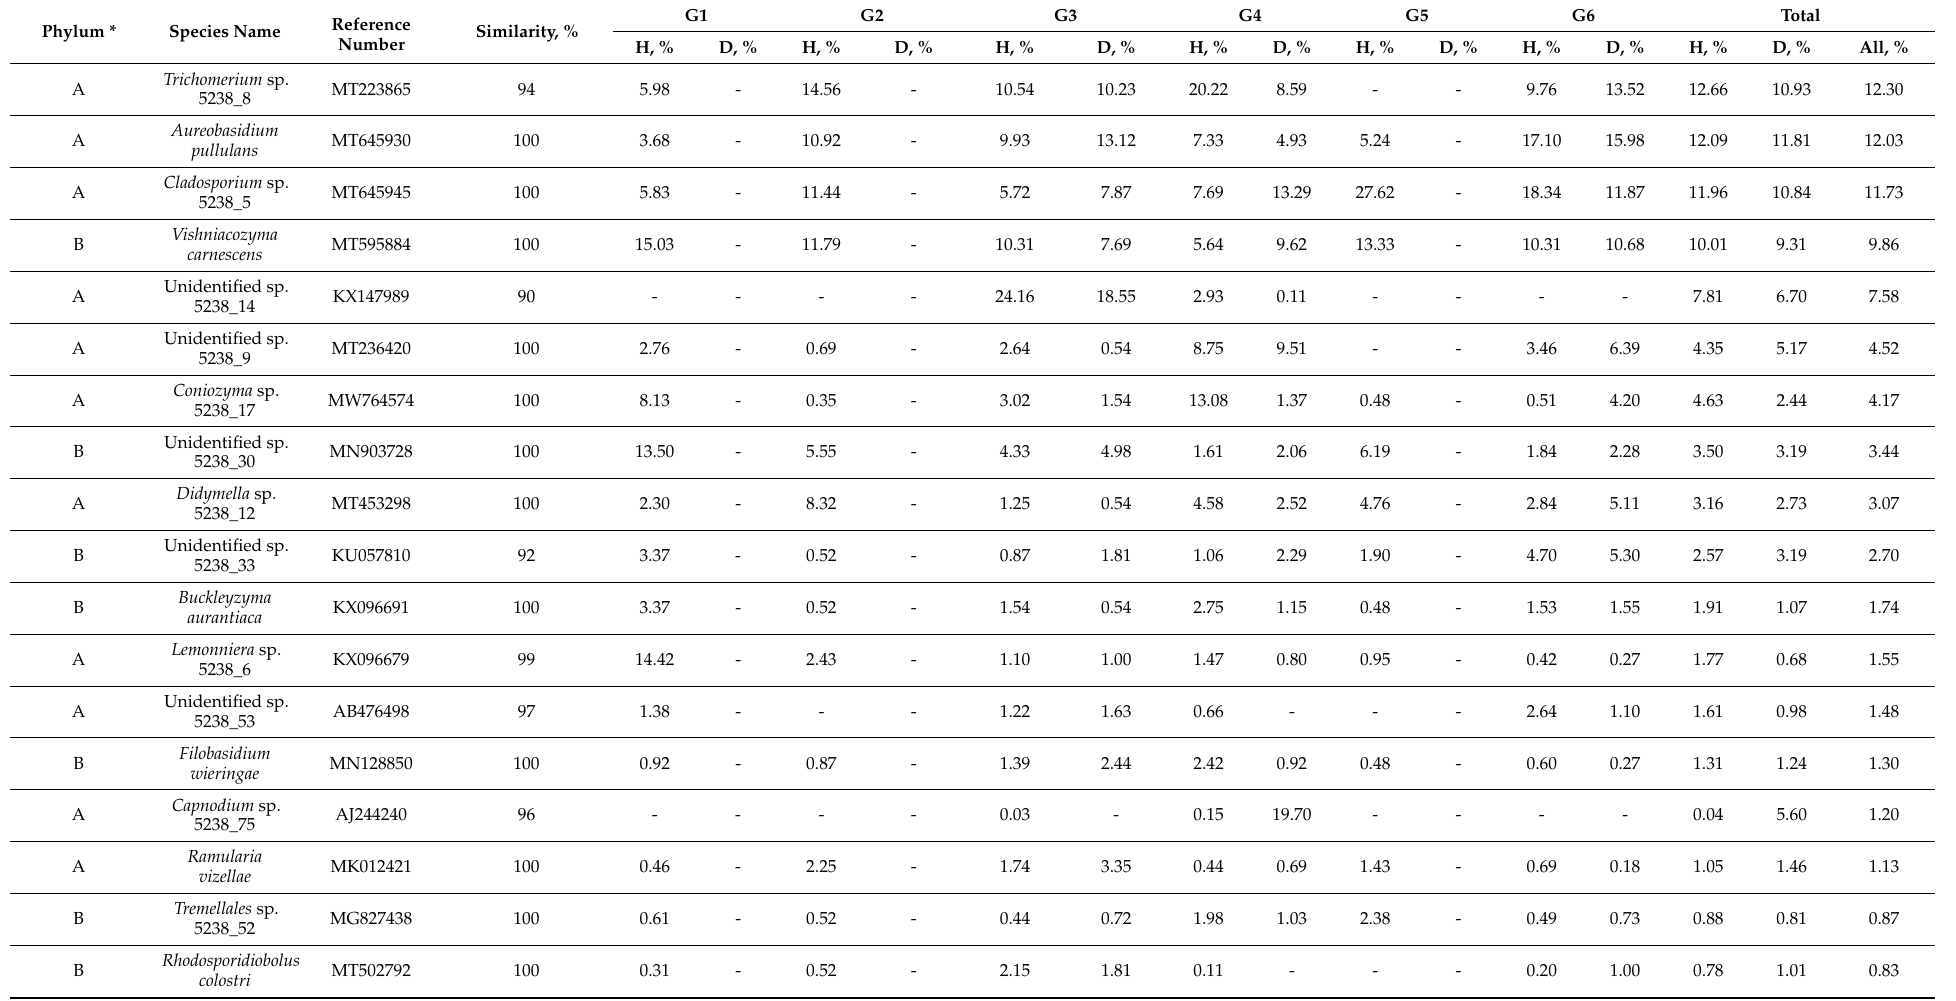
Table 4. Occurrence and relative abundance of the 30 most common fungal taxa (shown as a proportion of all high-quality fungal sequences) in leaves of healthy-looking (H) and diseased (D) trees of Ulmus glabra sampled from different sites (G1–G6) in